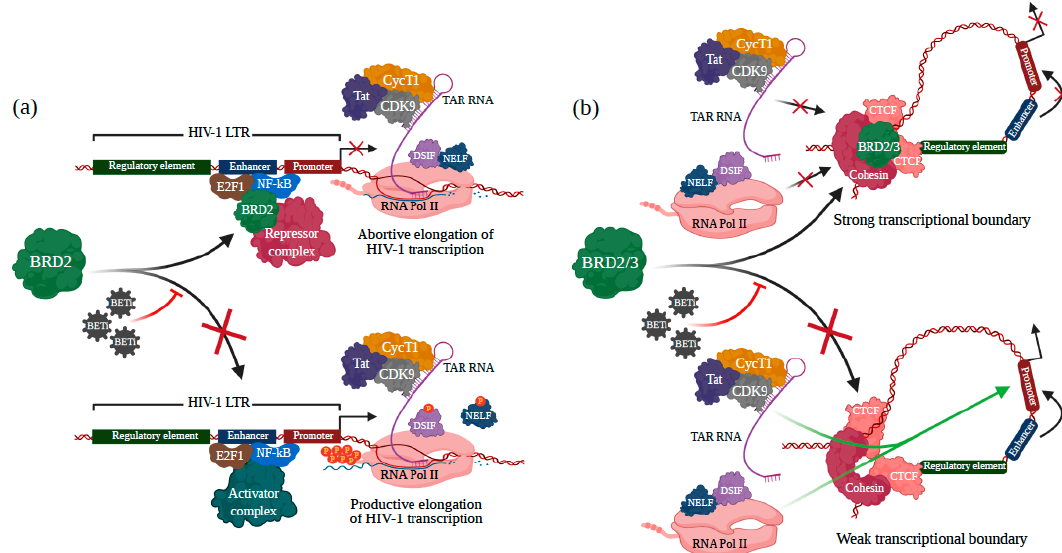
Figure 3. Roles of BET proteins and BETis in HIV-1 latency through the Tat-independent manner. ( a ) NF- κ B and E2F1 initially recruit BRD2 to the viral LTR site (which consists of a regulatory element, an enhancer, and a promoter), and BRD2 recruits further the repressor complex by recognizing the acetylated lysine residue on such complex. The formation of the repressor complex represses HIV-1 transcription. When BETis inhibit BRD2, the activator complex binds to the viral LTR site, leading to the activation of viral transcription. ( b ) CTCF recruits BRD2 or BRD3 (BED2/3) to interact with the CTCF-cohesin complex and forms a transcriptional boundary that interrupts the viral transcription. BRD2/3 induces a strong transcriptional boundary that may modify the chromatin structure and interfere with the accessibility of HIV-1 transcription components. Hence, BRD2/3 inhibited by BETis weakens the transcriptional boundary and enhance the HIV-1 transcription by causing relaxed chromatin structure and facilitating the accessibility of transcription components to the viral genome site. The figure was created with BioRender.com.